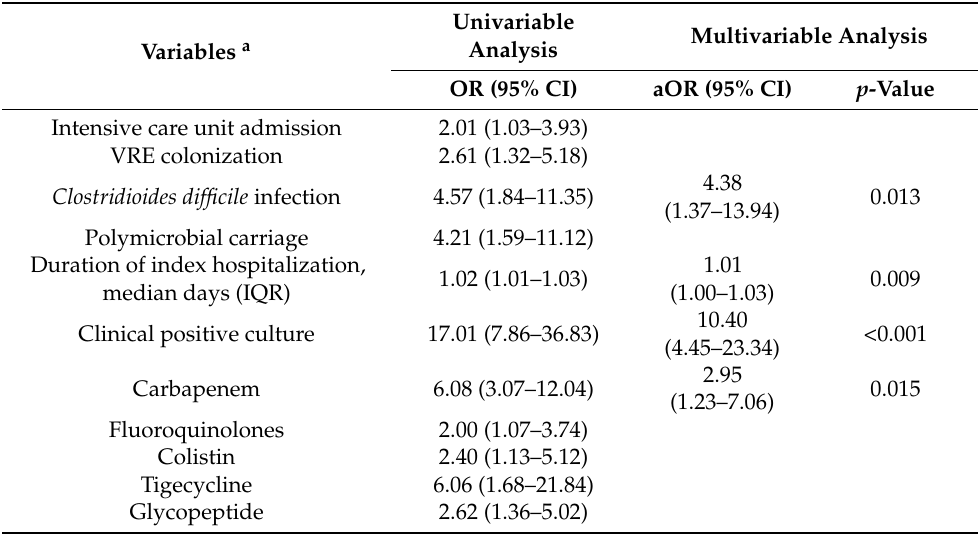
Table 4. Univariable and multivariable analyses of risk factors for prolonged carriage after 3 months among the selected patients with carbapenemase-producing K. pneumoniae colonization ( n =